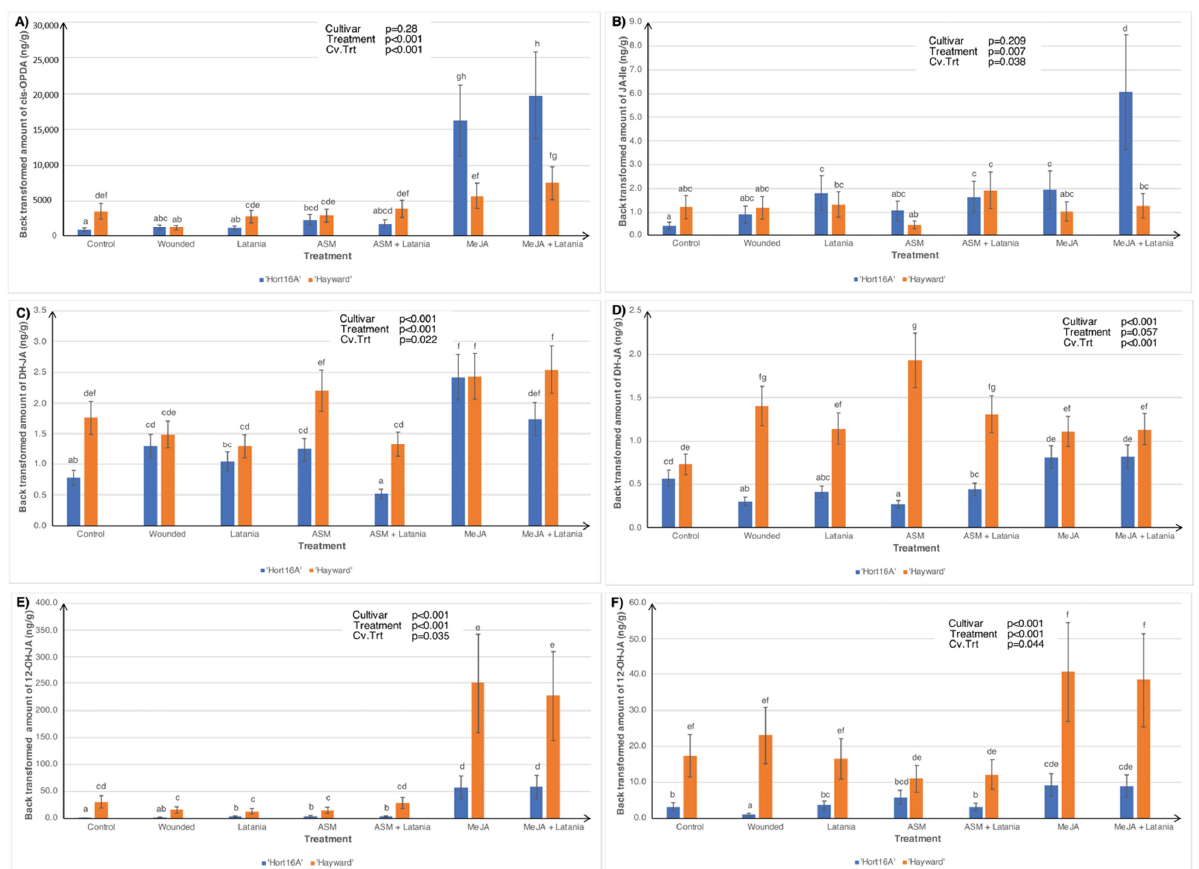
Figure 3. Phytohormone concentrations in ‘Hort16A’ and ‘Hayward’ kiwifruit leaf tissue, in 2018, of cis-12-oxyphytodienoic acid (cis-OPDA)—a JA precursor, at two days post latania scale infestation (psi), in ( A ); jasmonic acid isoleucine (JA-Ile)—the most bioactive form of JA, at two days psi, in ( B ); dihydrojasmonic acid (DH-JA)—a less active form of JA, at two days psi, in ( C ); DH-JA, at seven days psi, in ( D ); 12-hydroxy jasmonic acid (12-OH-JA)—an inert storage form of JA, at two days psi, in ( E ); and 12-OH-JA, at seven days psi, in ( F ). Treatments are described in full in Figure 2. Although leaves were sampled for both two and seven days psi for phytohormone measurements, only the statistically significant cultivar × treatment interactions (Cv.Trt) are presented. There were five replicate plants per treatment. The Y-axis concentration scale is different for each phytohormone. P-values from ANOVA are shown in the top right-hand corner of each bar chart. Error bars give the standard errors, and different lettering (a–h) indicates statistically significant treatment differences, as shown by LSD, p ≤